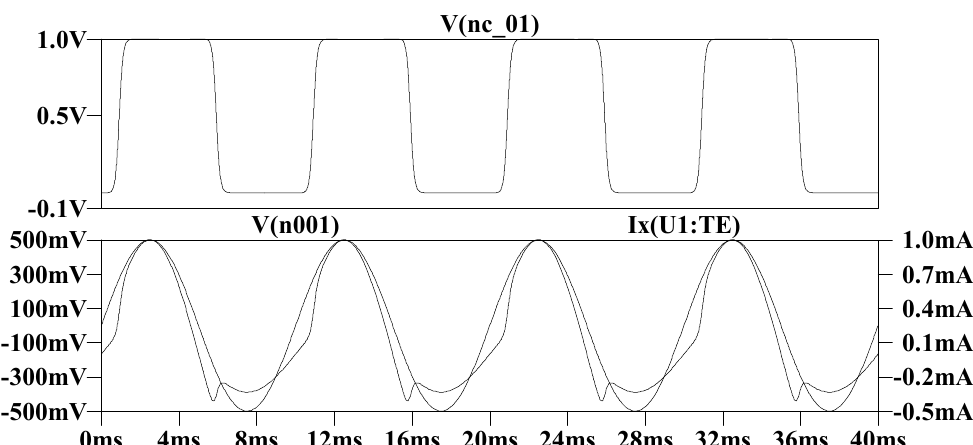
Figure 1. Memristor simulation circuit, MEM_ Knowm is the model of Knowm memristor, and XSV is the state variable. ( a ) Schematic ( b ) Knowm memristor model.